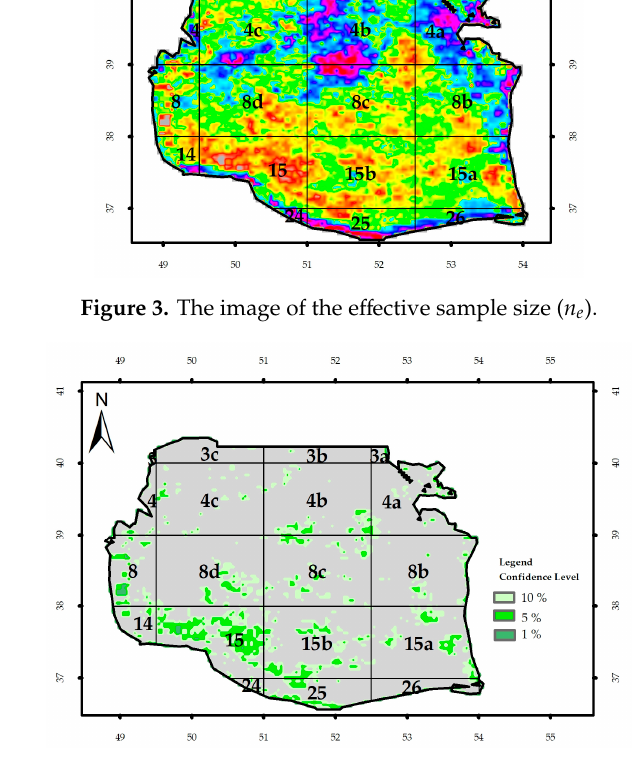
Figure 3. The image of the effective sample size ( n e ).